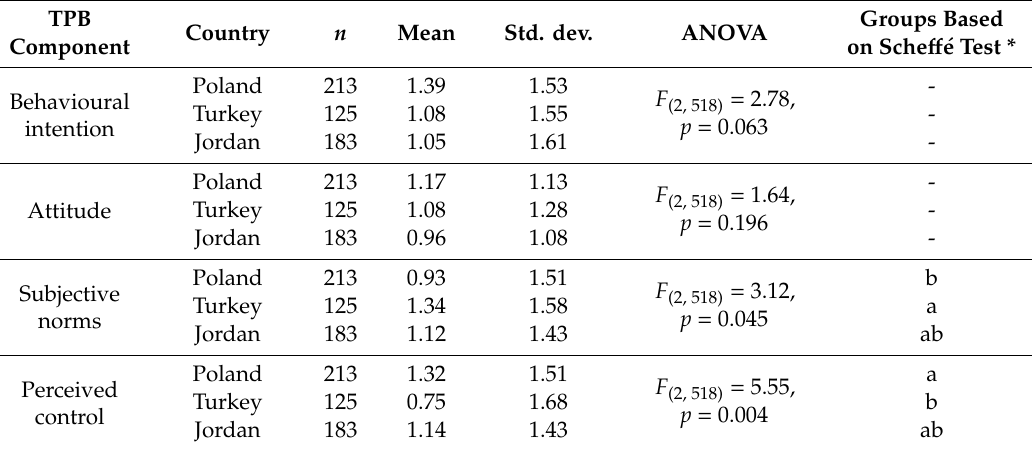
Table 2. Descriptive statistics, ANOVA, and post hoc analysis for TPB components, by